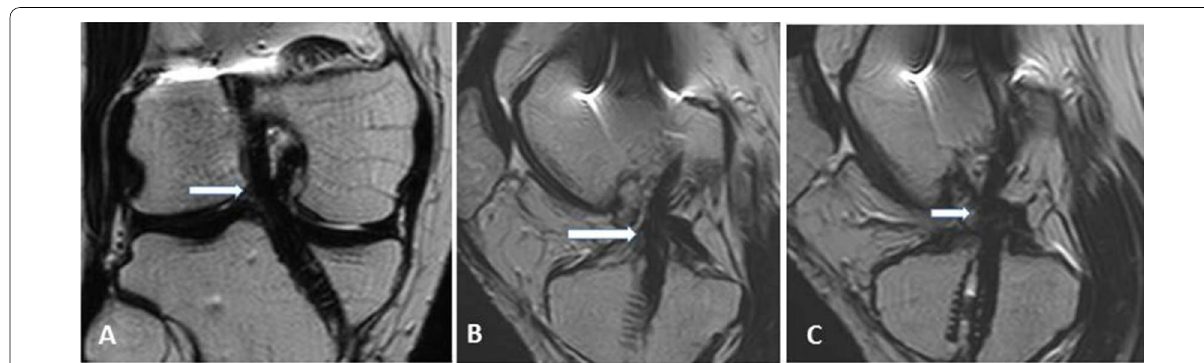
Fig. 2 a , Coronal T2 WIs; b and c , sagittal T2 WIs showing an intact graft having a low signal intensity, well-preserved continuation and a taut orientation (thick white